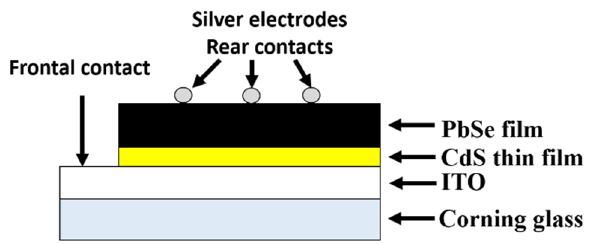
Figure 1. Scheme of the device based on the ITO/CdS/PbSe heterostructure.